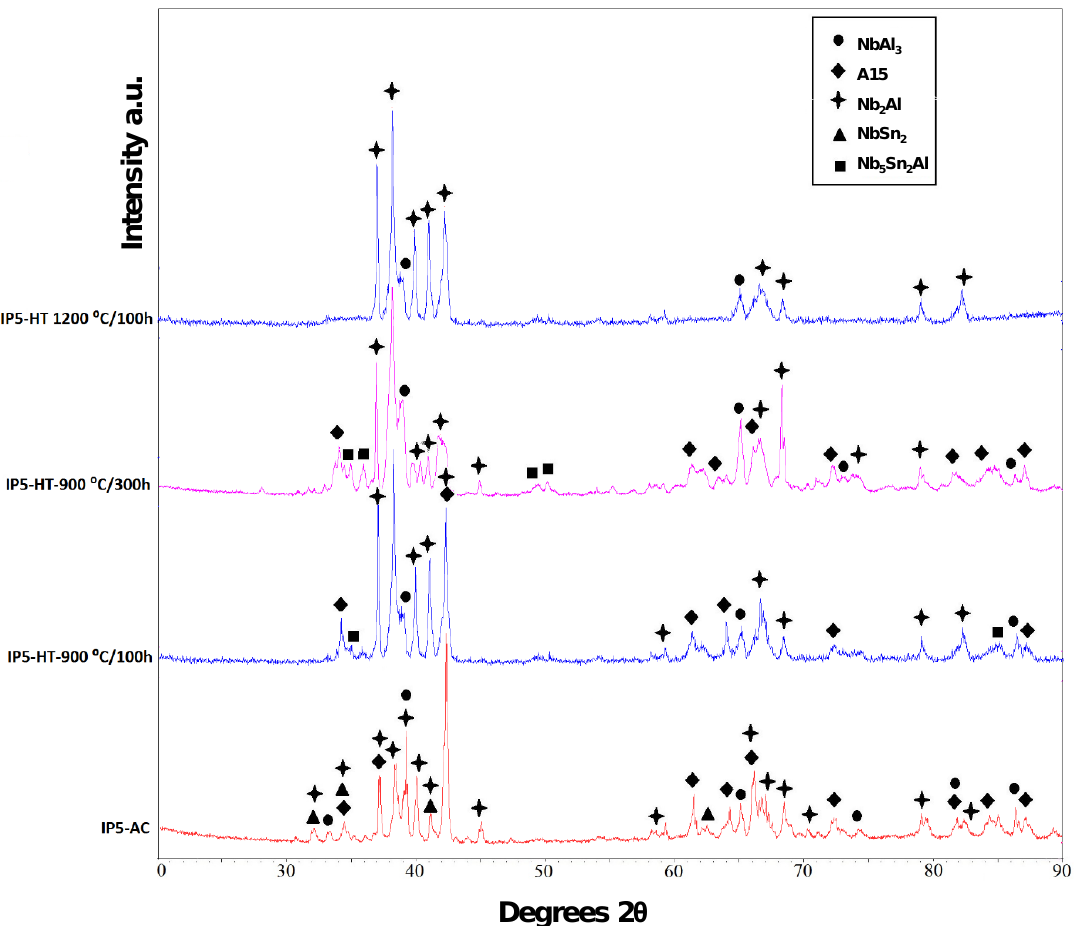
Figure 4. XRD patterns of IP5-AC, IP5-HT-900 °C/100 h, IP5-HT-900 °C/300 h and IP5-HT-1200 °C/100 h .